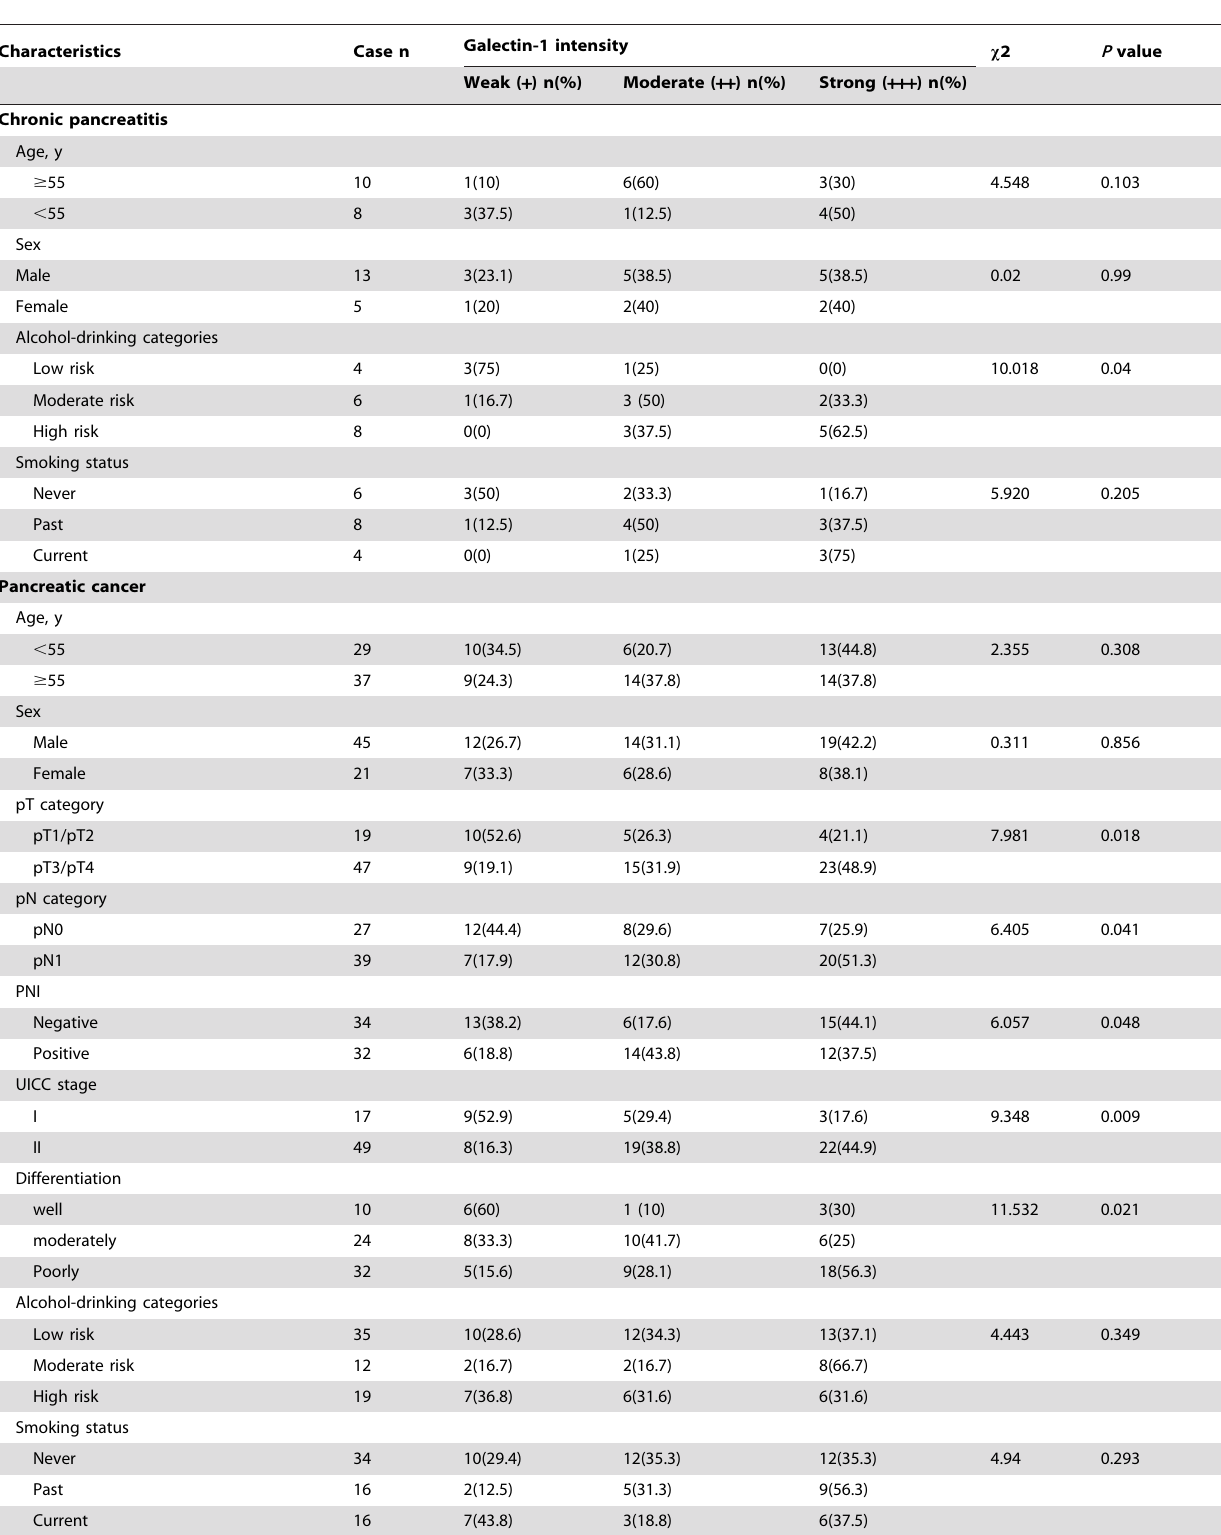
Table 1. Galectin-1 intensity of staining and clinicopathologic characteristics of the 18 patients with chronic pancreatitis and 66 patients with pancreatic